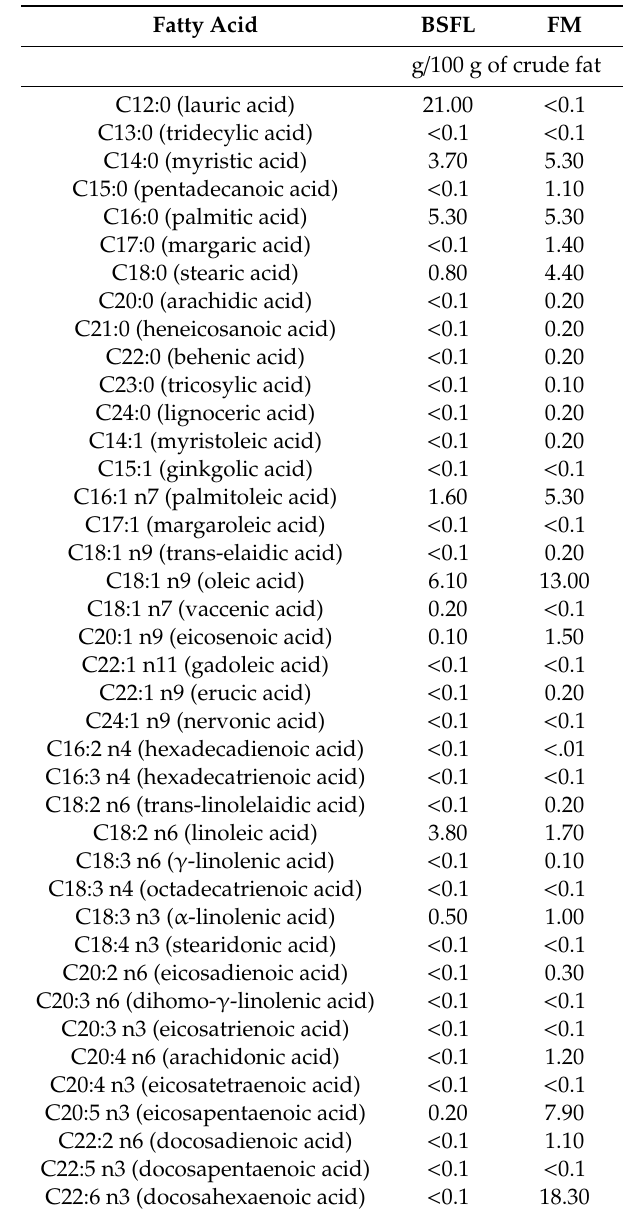
Table 2. Fatty acid profile of Black soldier fly larvae full-fat meal (BSFL) and fish meal (FM). Fatty Acid BSFL FM g / 100 g of crude fat C12:0 (lauric